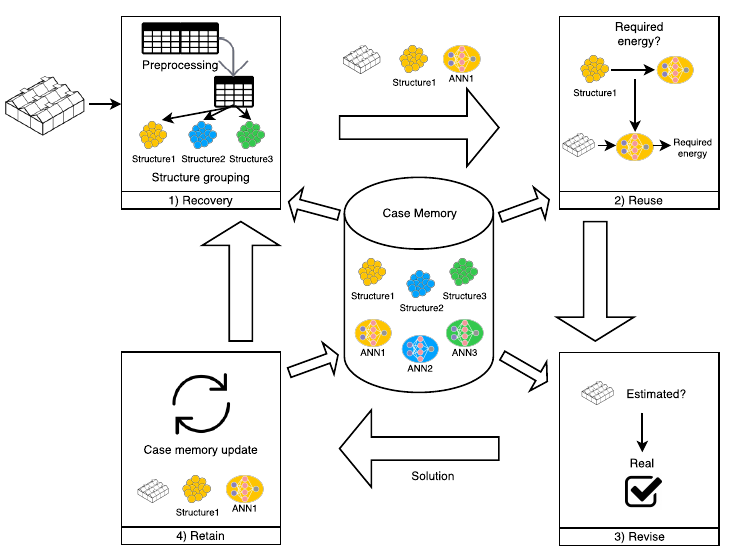
Figure 3. CBR cycle to predict the required